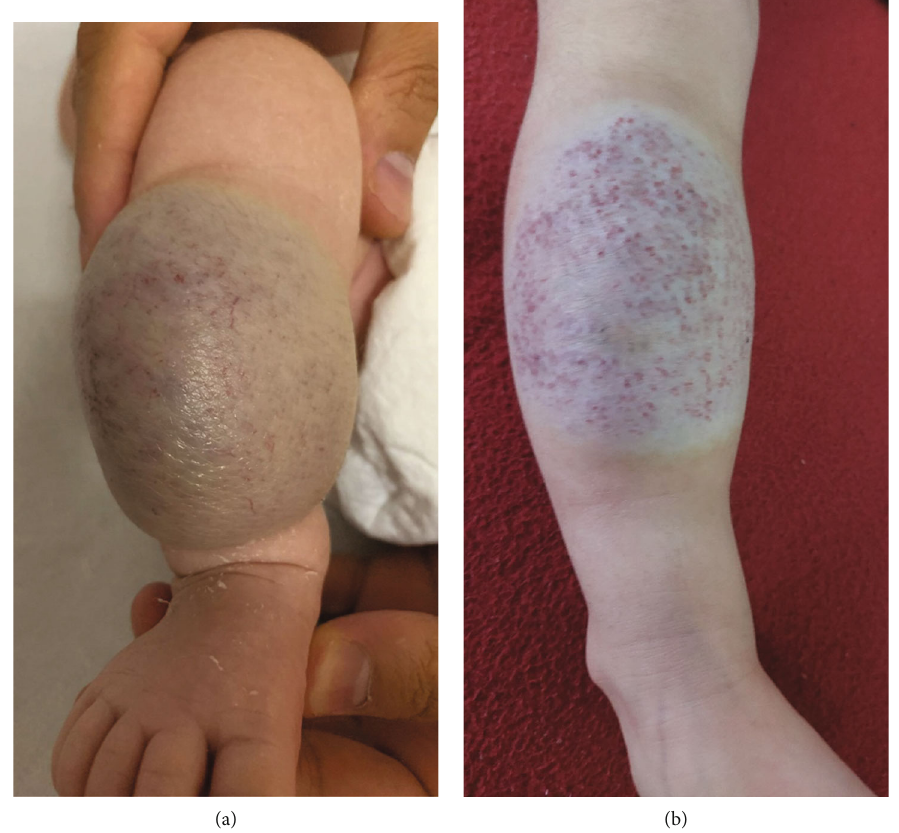
Figure 3: Picture of the tibial AVM in patient 3. (a) Before EVOH embolization. (b) At